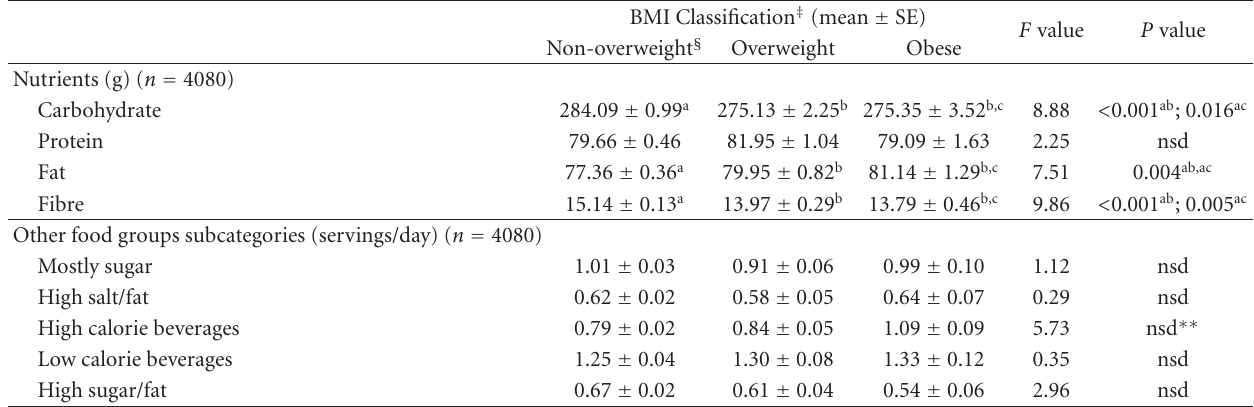
Table 2: Group di ff erences in adjusted ∗ nutrient intakes based on BMI classification † .